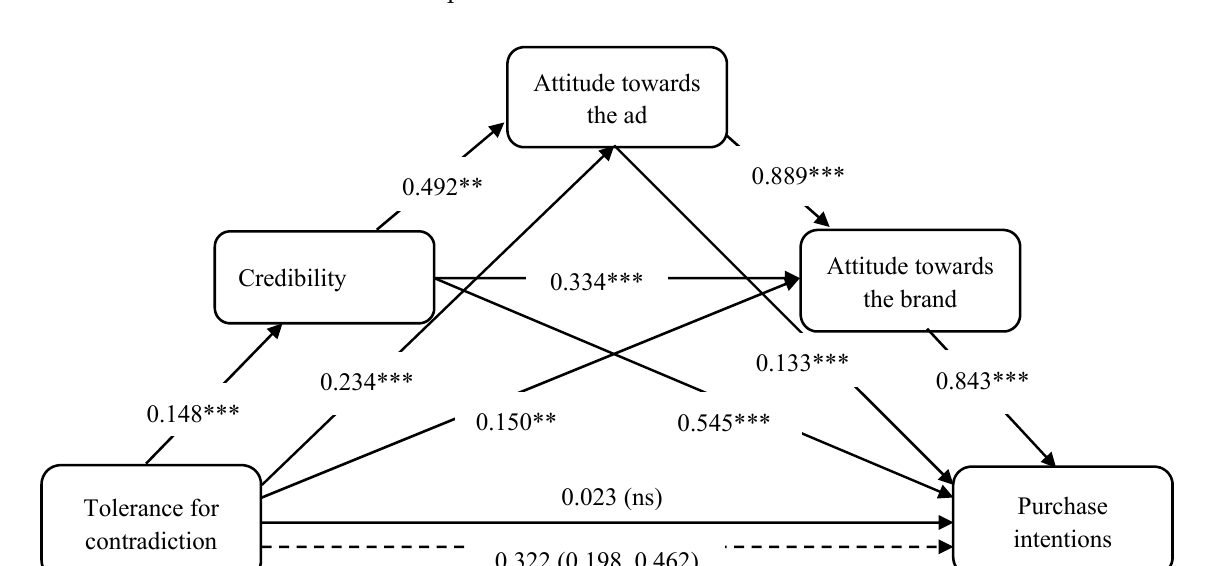
Figure 5. Conceptual model with results for Easterners. Note: ** p < 0.01, *** p < 0.001.